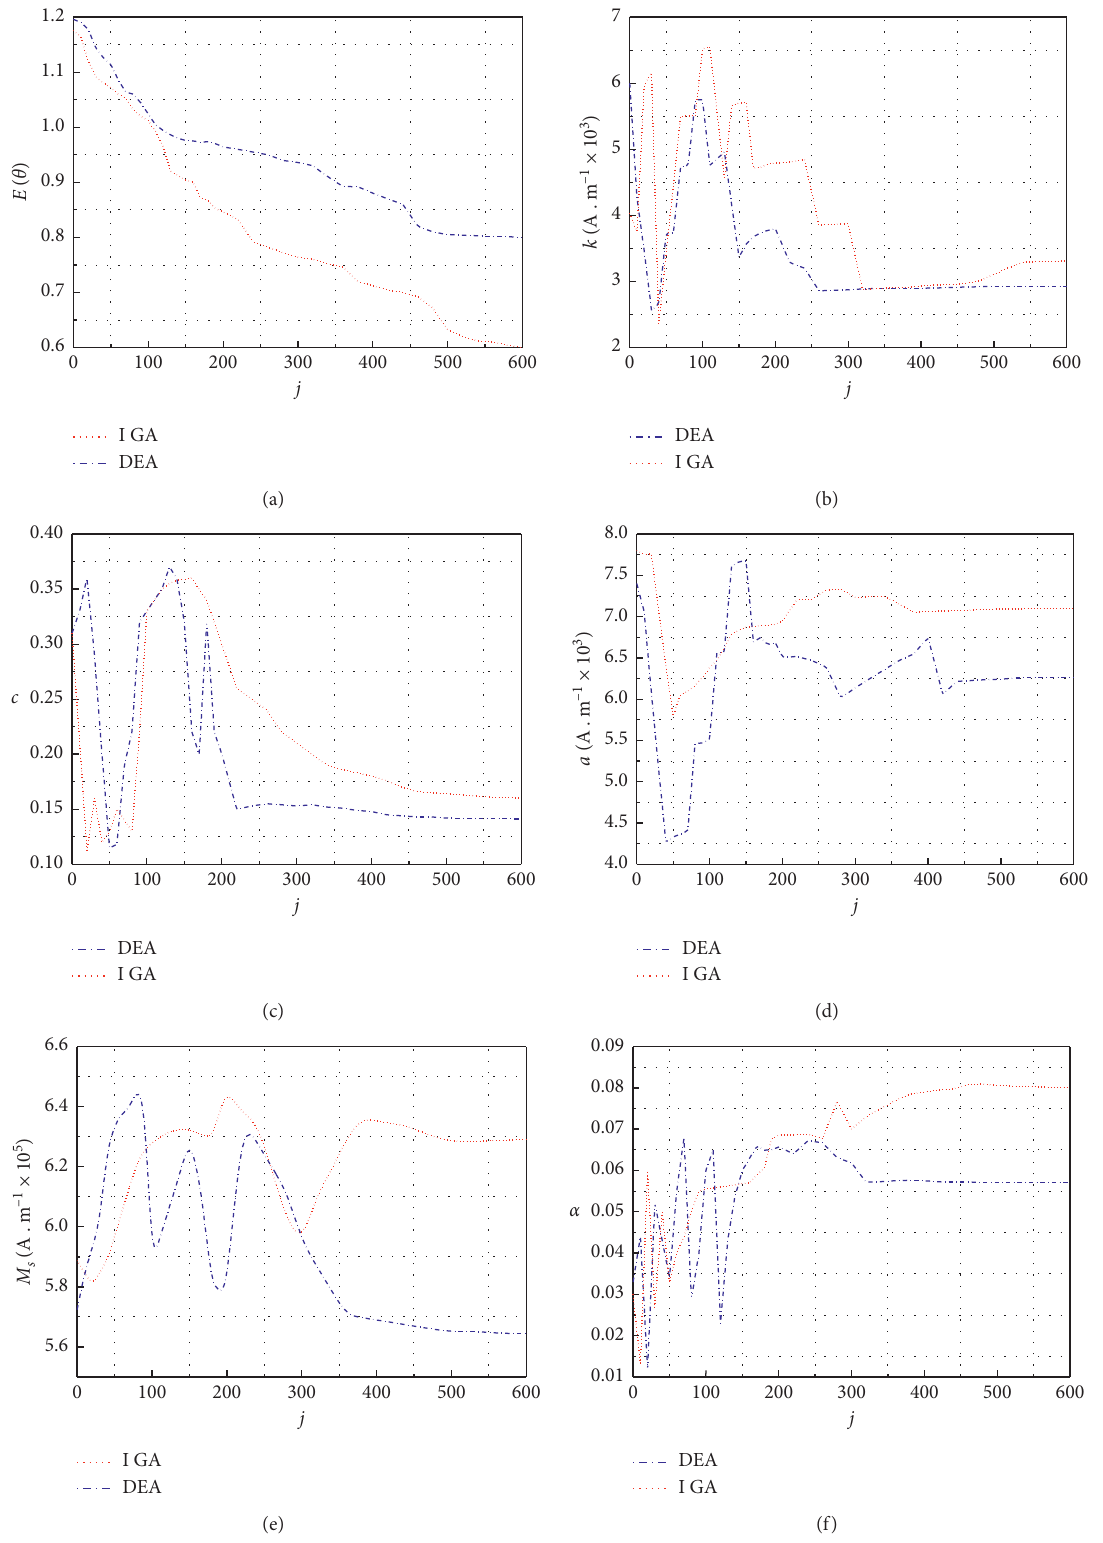
Figure 5: Iterative process of objective function and identification parameters. (a) Objective function E ( θ ) .(b) Irreversible loss coefficient k . (c) Reversible coefficient c . (d) Shape coefficient of magnetization without hysteresis a . (e) Saturation magnetization M s . (f) Domain wall interaction coefficient α